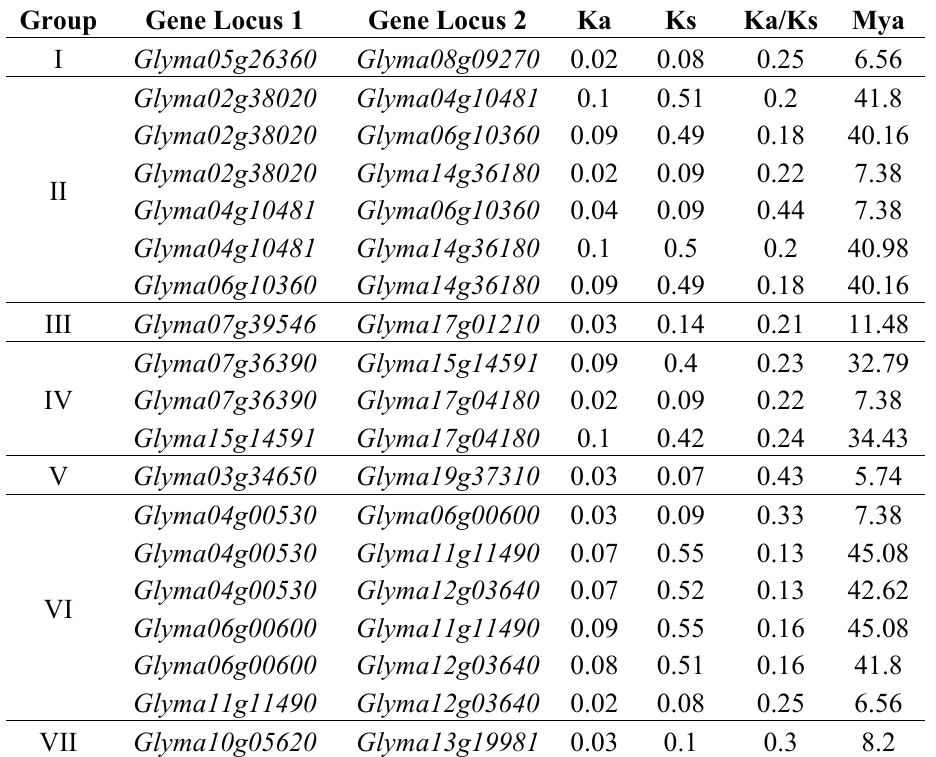
Table 2. Estimates of the dates for the segmental duplication events in the HECT gene pairs in